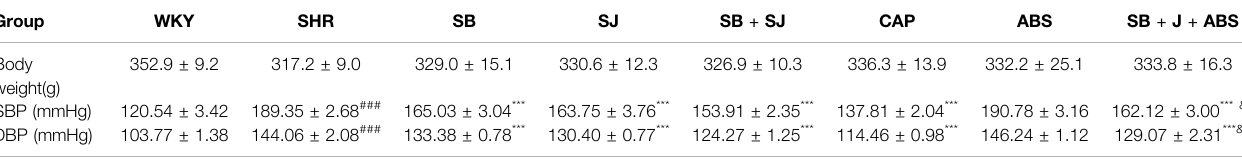
TABLE 2 | Effects of thecombination of SB and SJ on body weight and blood pressure of SHR. Group WKY SHR SB Body weight(g)